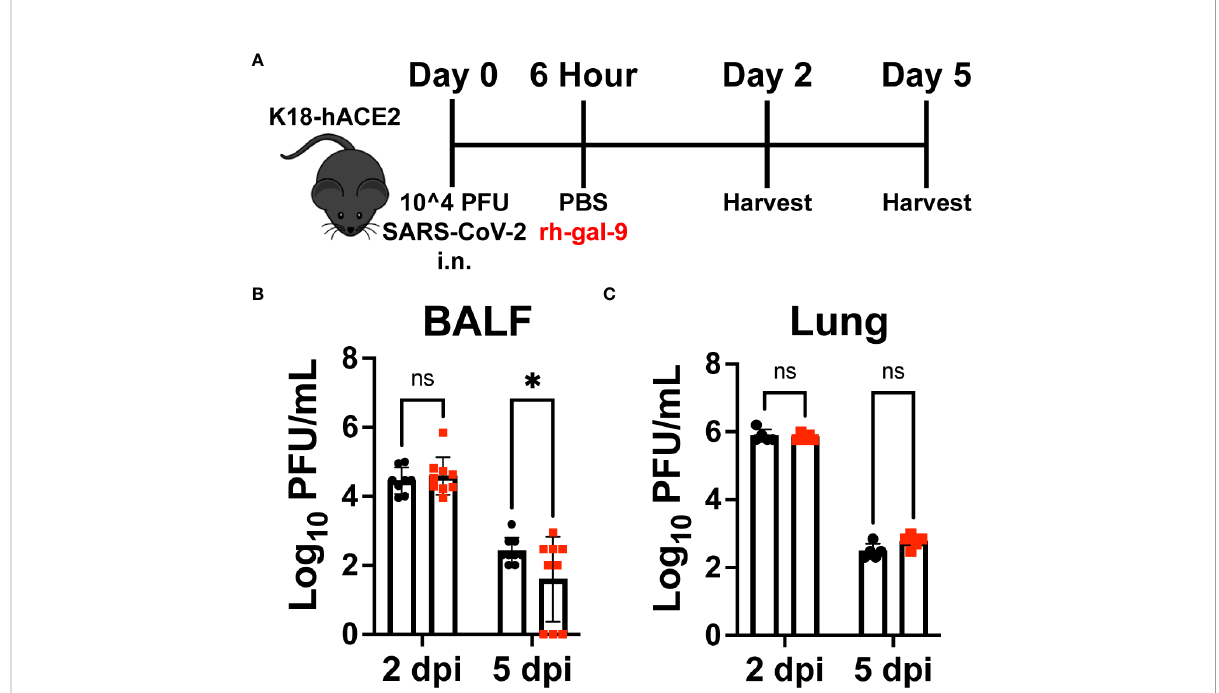
FIGURE 4 rh-gal-9 treated mice exhibit enhanced viral clearance in the alveoli space but not in the parenchyma. (A) Schematic for experiment plan for all timepoint studies. (B) Bronchial Alveolar Lavage Fluid (BALF) and (C) Lung lysate viral titers by VeroE6 plaque assay at 2- and 5- dpi of PBS (black) or rh-gal-9 (red) treated mice. n = 6-9/group, *p<0.05 and ns, not signi fi cant, Two-way ANOVA with Sidak Correction. Data are represented as mean +/-